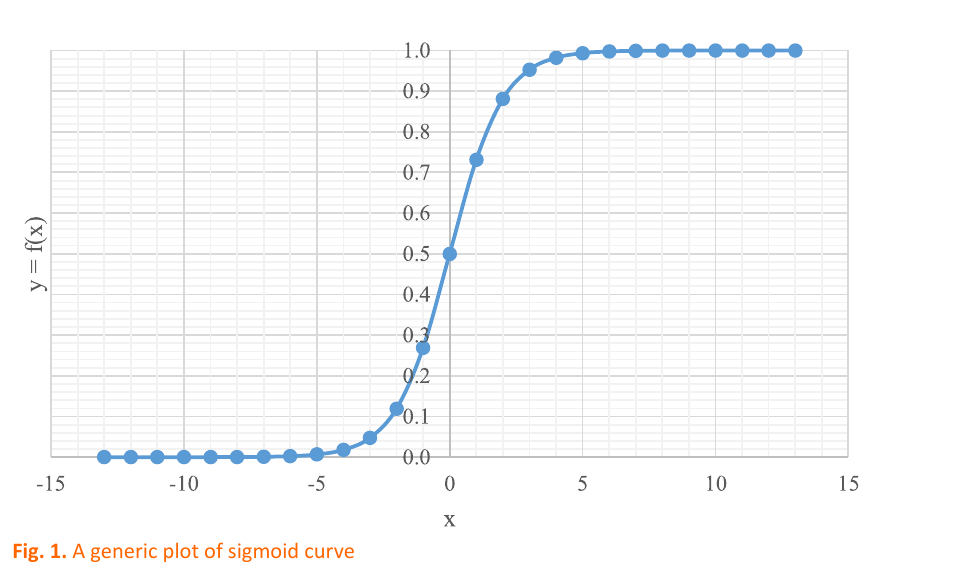
Fig. 1. A generic plot of sigmoid